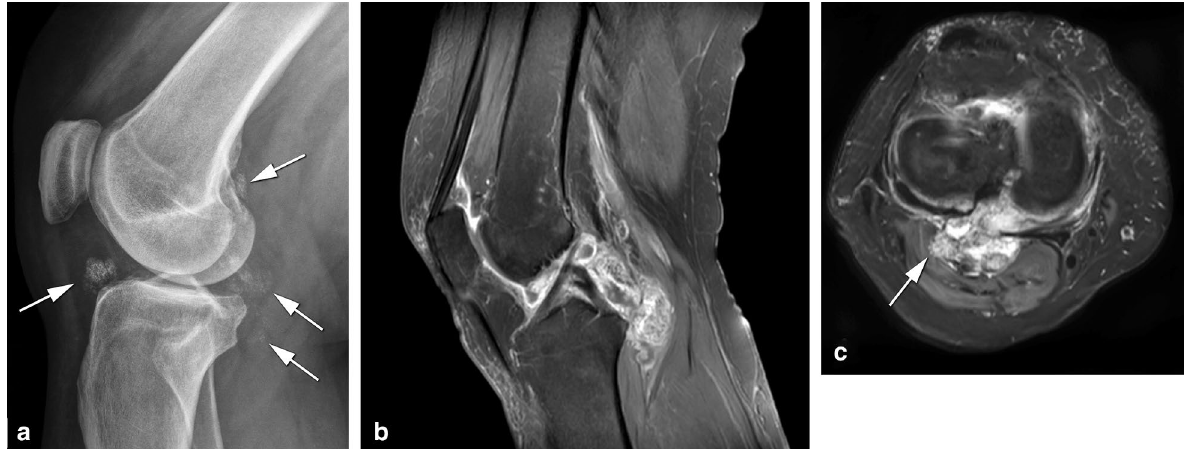
Fig. 5 Differential diagnosis: synovial chondromatosis in the knee. a Lateral radiograph illustrating multiple punctiform masses in the soft tissues of the knee containing speckled calcifications (arrows). These calcifications are present in Hoffa and posterior in the knee. b Sagittal T1 SPIR post contrast showing rim enhancement of the synovial lesions, which contain low signal intensity foci corresponding to the calcifications on X-ray. Only minimal joint effusion is present surrounding the cruciate ligaments with rim enhancement. c Axial T2 DIXON shows posterior extracapsular